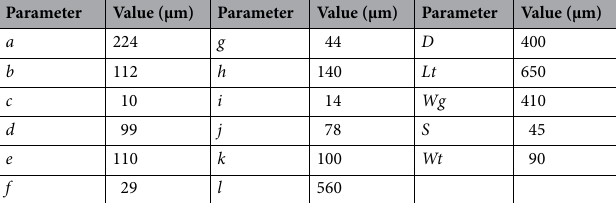
Table 1. Design parameters.